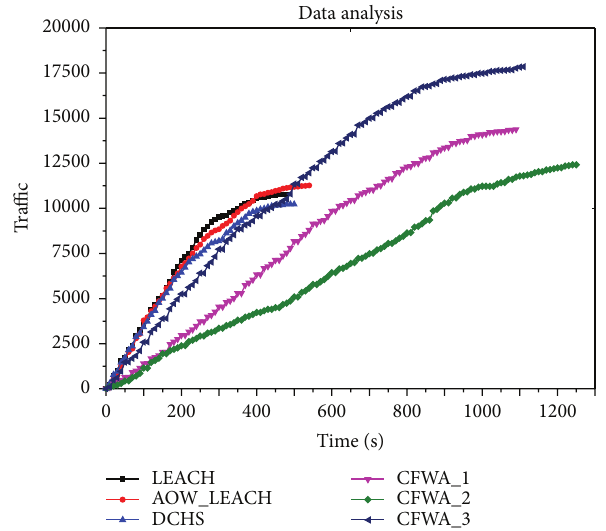
Figure 13: Traffic comparison diagram between CFWA family algorithms and LEACH-like algorithms in 500